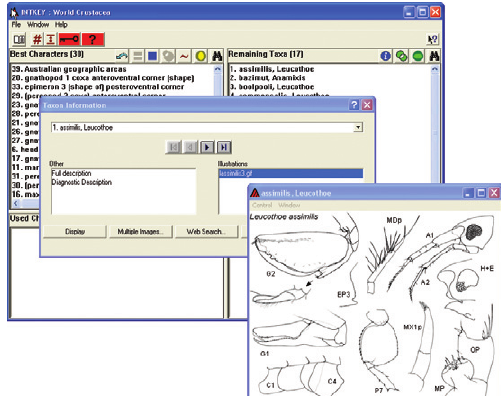
Figure 58. Display of a taxon